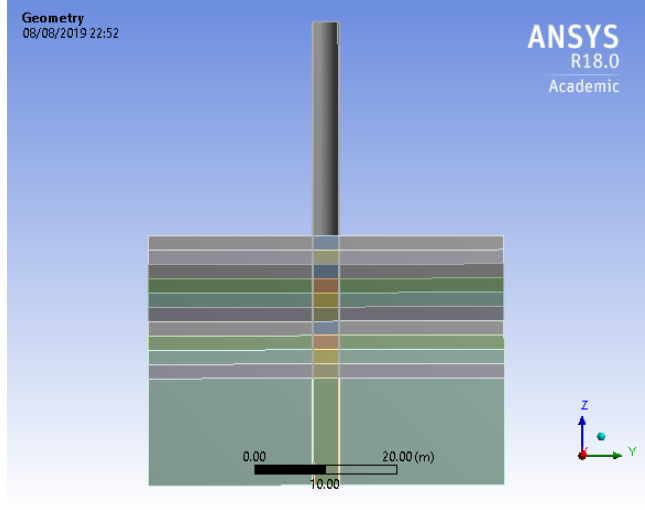
Figure 10. Model with 11 layers of soil, used for validation with the centrifuge test.